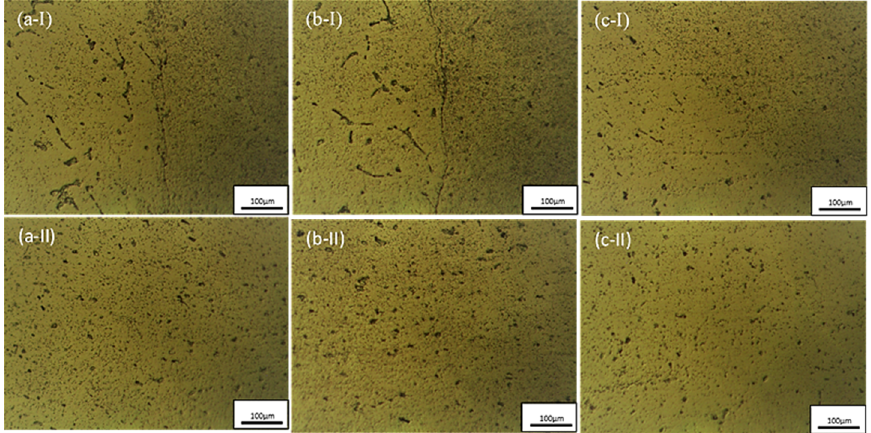
Figure 21. Microstructure of FSPed surface using TTH tool at 1250 rpm for feed rates of, ( a ) 20 mm/min, ( b ) 25 mm/min, and ( c ) 30 mm/min of different regions, whereby (a-I–c-I) is HAZ-SZ boundary and (a-II–c-II) is the SZ.